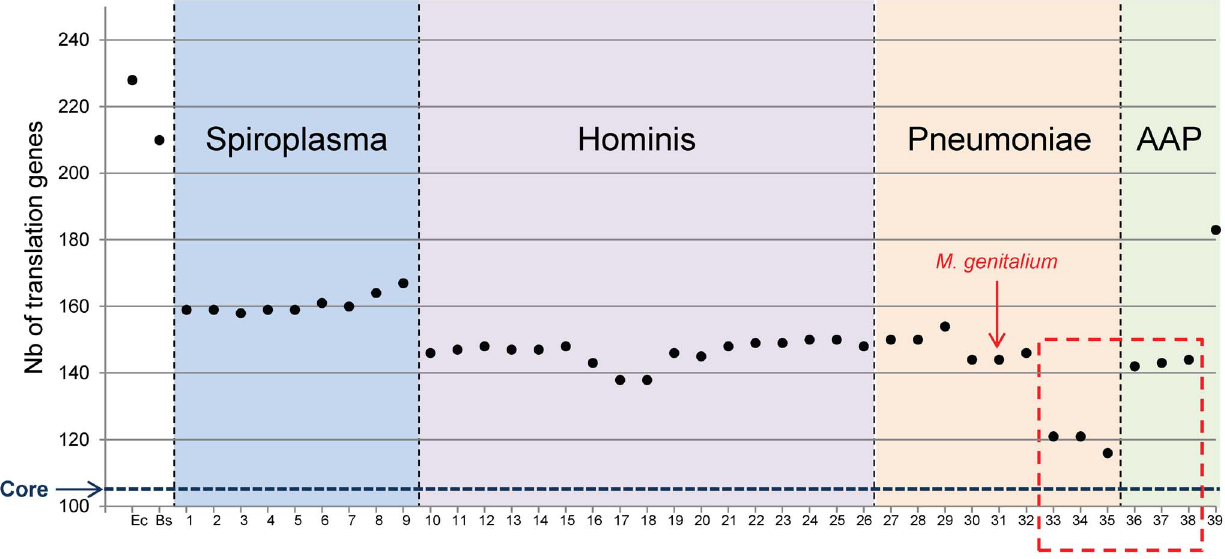
Figure 2. Total number of proteins involved in translation for each Mollicutes species. The number of proteins involved in translation for each Mollicutes species was tabulated in reference to the number found for the two model bacteria E. coli (Ec) and B. subtilis (Bs). The numbering of species is the same as in Figure 1. The data corresponding to non-cultivated Mollicutes are framed with a red dashed line as in Figure 1. The horizontal blue dashed line indicates 104, which correspond to the core of translation proteins shared by all Mollicutes.